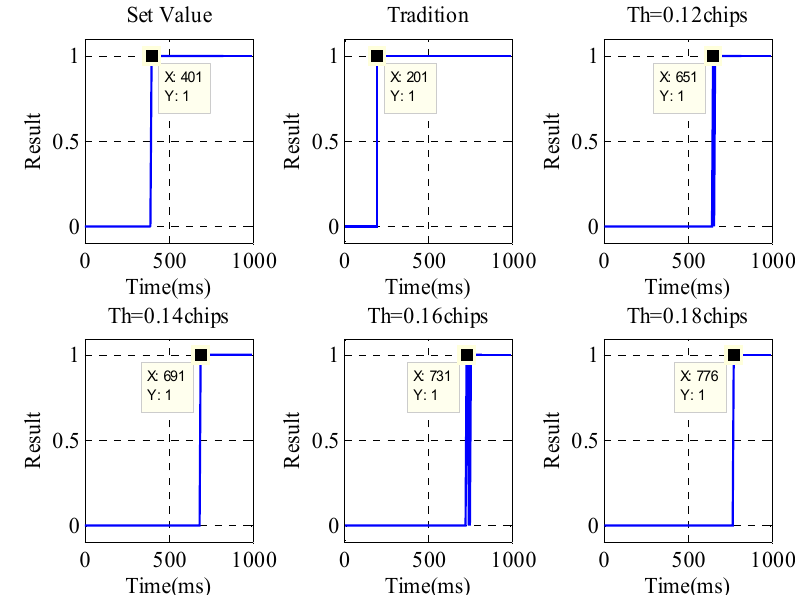
Figure 16. Deception interference detection results in interference scenarios.